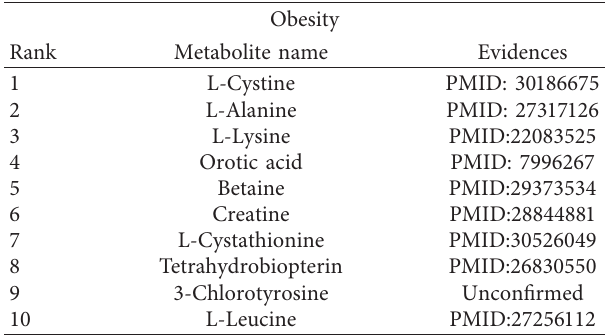
Table 5: Candidate metabolites of obesity.